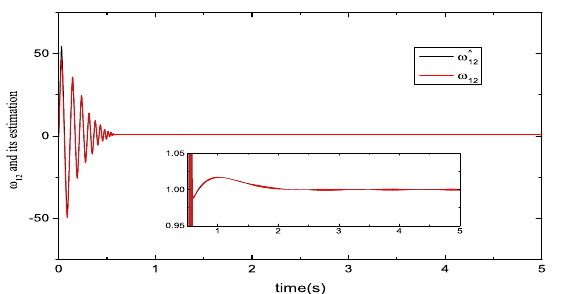
Figure 6. Estimated performance evaluation curves of four motor velocities: velocity ω 1 and its estimated value curve.